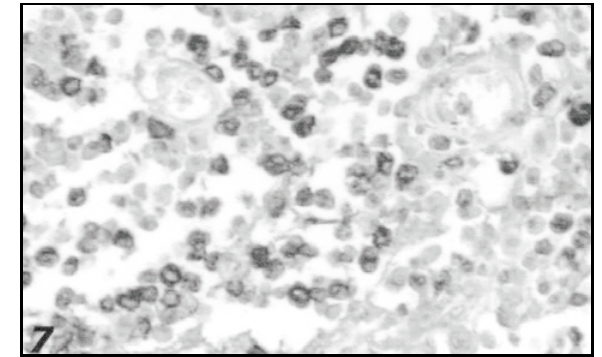
Figure 7 – Cutaneous histiocytoma, anti-lysozyme, cytoplasm staining (x